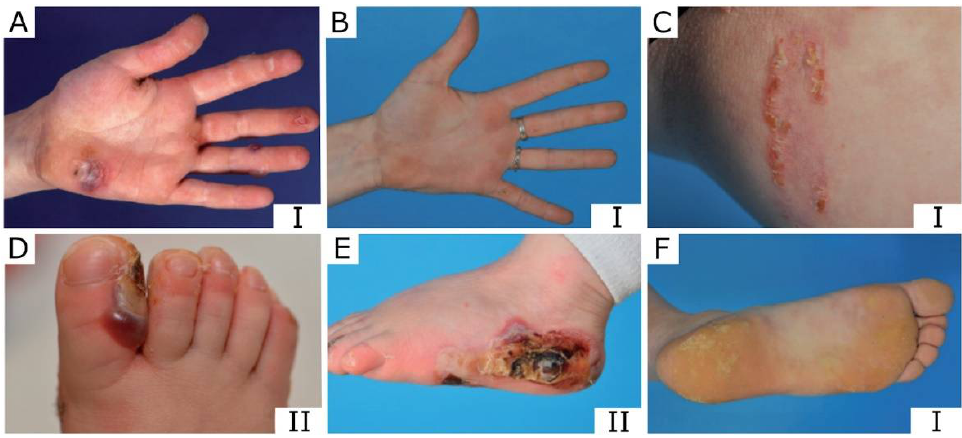
Figure 2. Clinical pictures of patients affected by epidermolysis bullosa simplex (I and II), generalized severe (EBS-sev.). ( A ) Blistering of the palm at 6 years of age with surrounding subtle hyperkeratosis. Bullae of the fingers with visible desquamation. ( B ) The same patient at 11 years of age, where amelioration of symptoms is seen. ( C ) Circinate blistering seen on the inner thigh. ( D ) Hemorrhagic blistering of the large toe, with focal hyperkeratosis and subtle onycholysis at 2 years of age. ( E ) Grouped hemorrhagic blisters on the lateral aspect of the foot of the same patient. ( F ) Generalized plantar keratoderma at 15 years of age. Images were adopted from